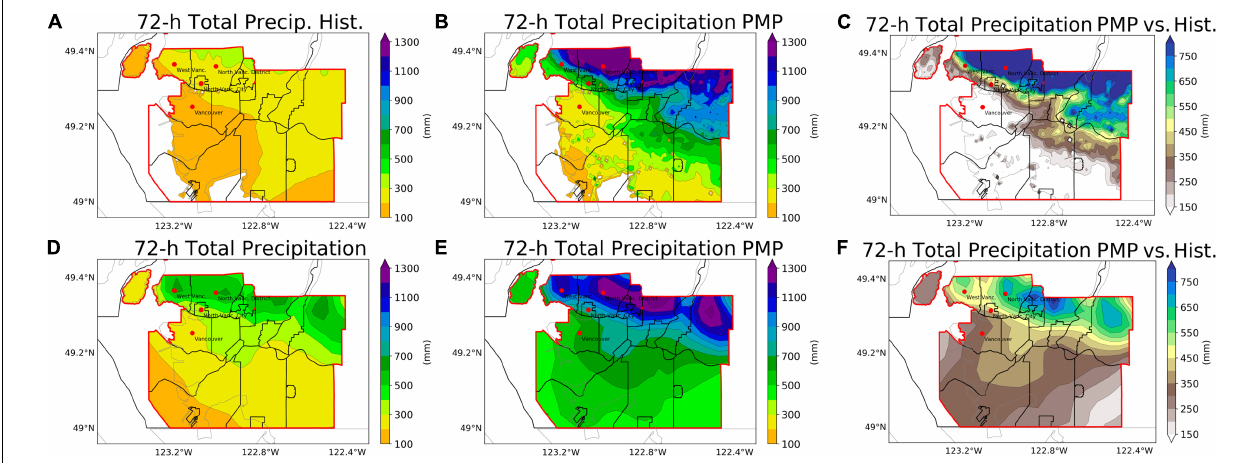
FIGURE 5 | Precipitation and PMP estimation from the GEV analysis based on Daymet (A–C) and simulations of GEMCLIM driven by spatially adjusted LBCs (D–F) for the 30 historical extreme precipitation events in Metro Vancouver during 1980 ∼ 2017: (A,D) the maximum 72-h total precipitation in the historical events; (B,E) PMP estimates; (C,F) precipitation increase for PMP relative to the historical events. Areas marked with red stippling illustrate Vancouver’s downtown